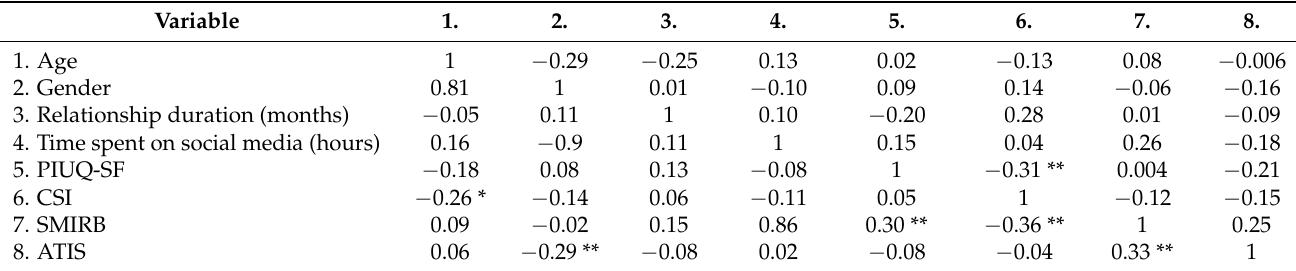
Table 3. Bivariate correlations between study variables for gay and lesbian (above) individuals and separately for heterosexual individuals (below).